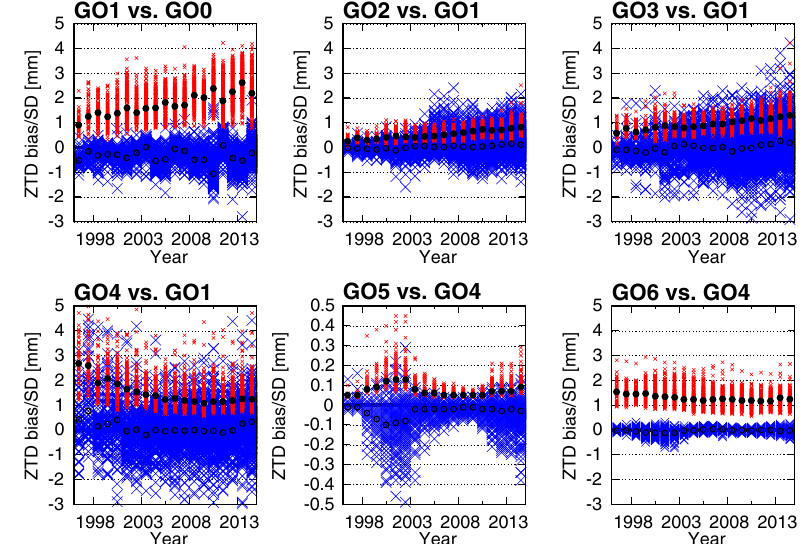
Figure 14. Dependence of ZTD biases (blue), mean biases (unfilled black circles), standard deviations (red) and mean standard deviations (filled black circles) from inter-comparisons of the GOP second reprocessing solution variants per year. Note the different y range for the GO5 vs. GO4 comparison.